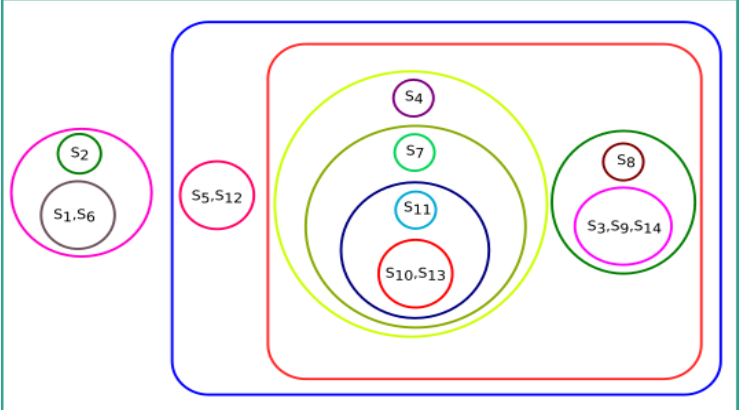
Figure 6. Clusters drawn from hierarchical clustering phylogenetic tree based on physicochemical properties. Here, S i represents the species name as specified in Table 1.